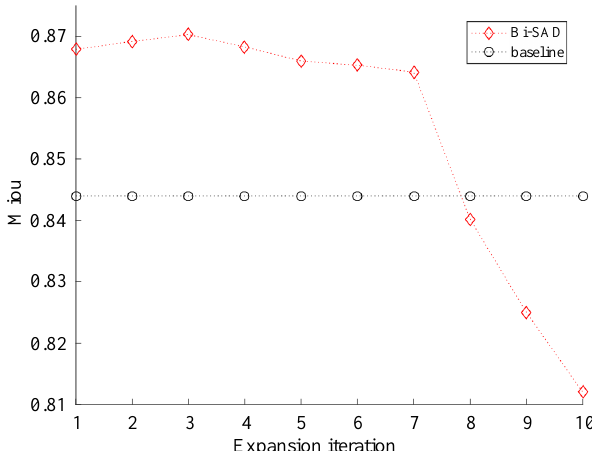
Figure 7. The resulting mIoU of the varying expansion iteration. The expansion iteration is the hyperparameter in Mask B and Mask I